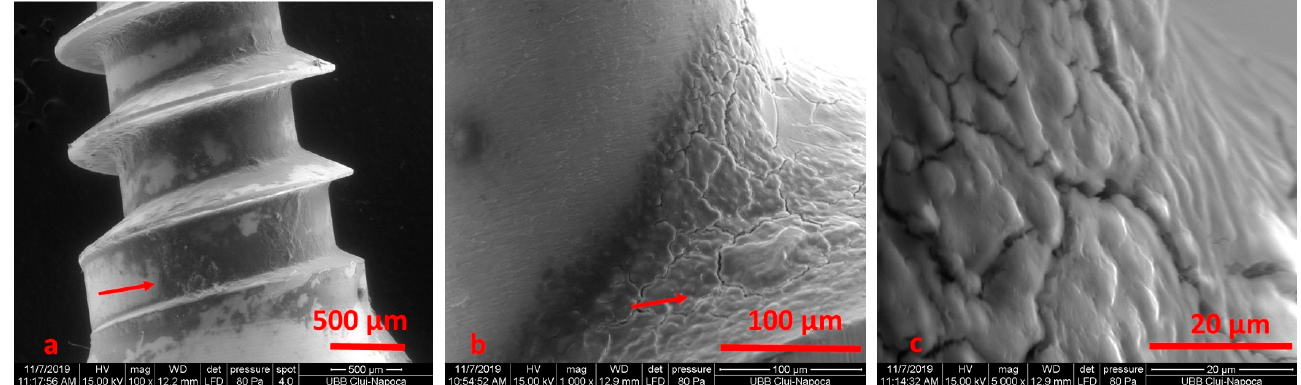
Figure 3. SEM micrographs of the surface screw, removed after 10 months, at ×100 ( a ), ×1000 ( b ) and ×5000 ( c ) magnification.